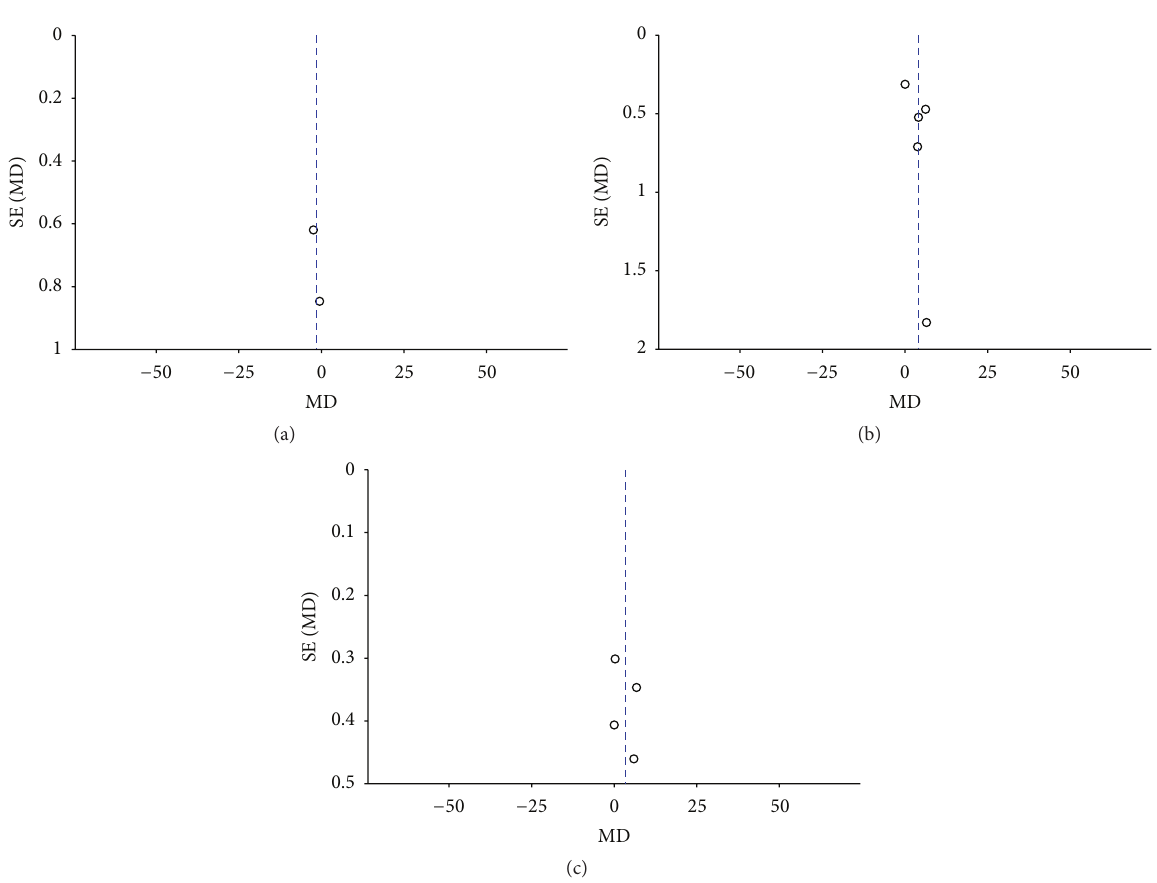
Figure 4: Forest plot of BUT changes using a random-effect model for the effect of HRT on DES patients. BUT: break-up time; HRT: hormone replacement therapy; DES: dry eye syndrome; SD: standard deviation; CI: confidence interval; and IV: inverse variance.